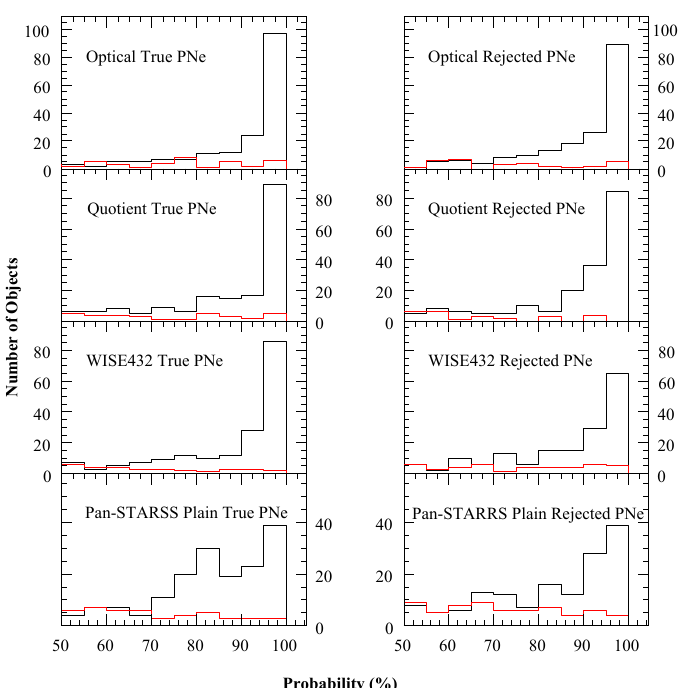
Figure 9. The histogram of the probabilities assigned by DenseNet201 DTL model to the PNe in the HASH Optical Test set. The x -axis shows the probability score assigned a PN to both classes. The y -axis shows number of objects per bin. The plots on the left show the True PNe and on the right the Rejected PNe. Black lines show correctly classified (true positives on the right, true negatives on the left) and red lines show the misclassified objects (false negatives on the left, false positives on the right).